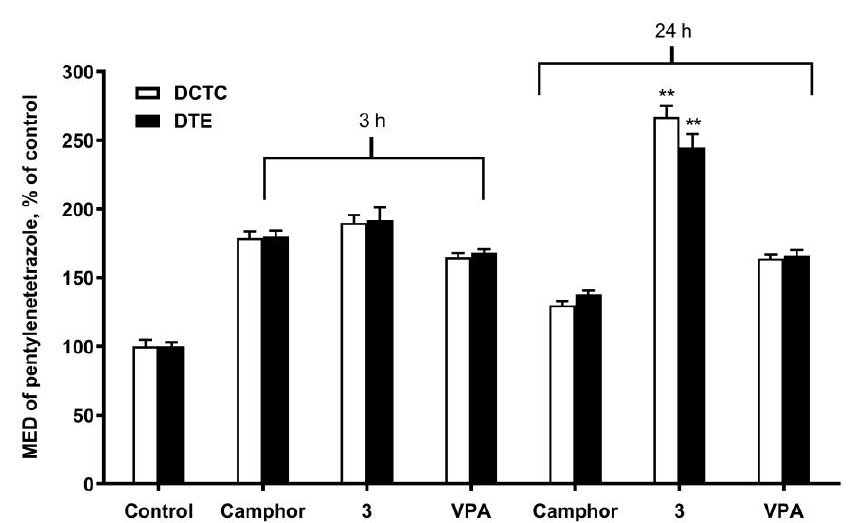
Figure 1. At 3 h and 24 h after oral administration. Values are given as mean ± SEM, n = 5 mice; for all groups p < 0.01 compared with the control; ** p < 0.01 compared with VPA.